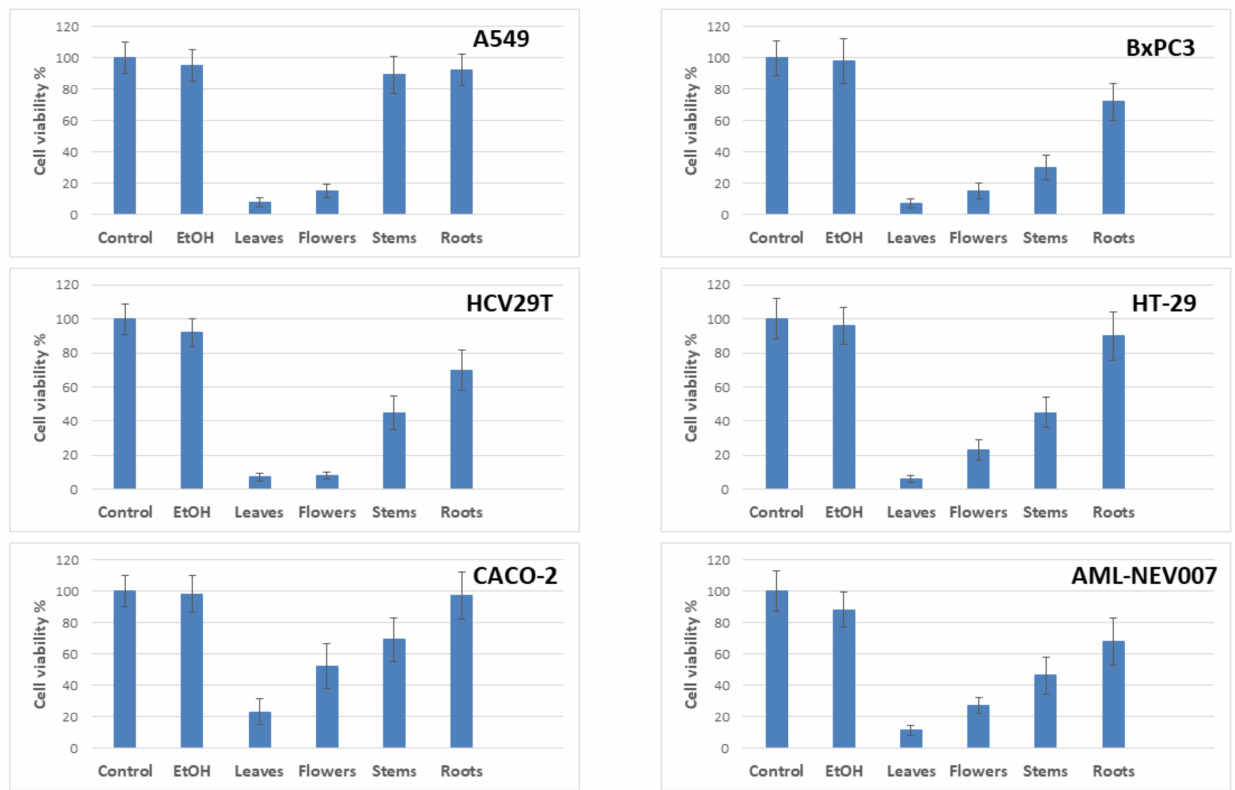
Figure 1. The viability of different cancer cells after treatment with 30% ethanolic extracts for 48 h. One 1:10 solid-to-liquid (S/L) ratio was used for all parts of the plant. Obtained extracts were diluted 30 times to final ethanol concentration